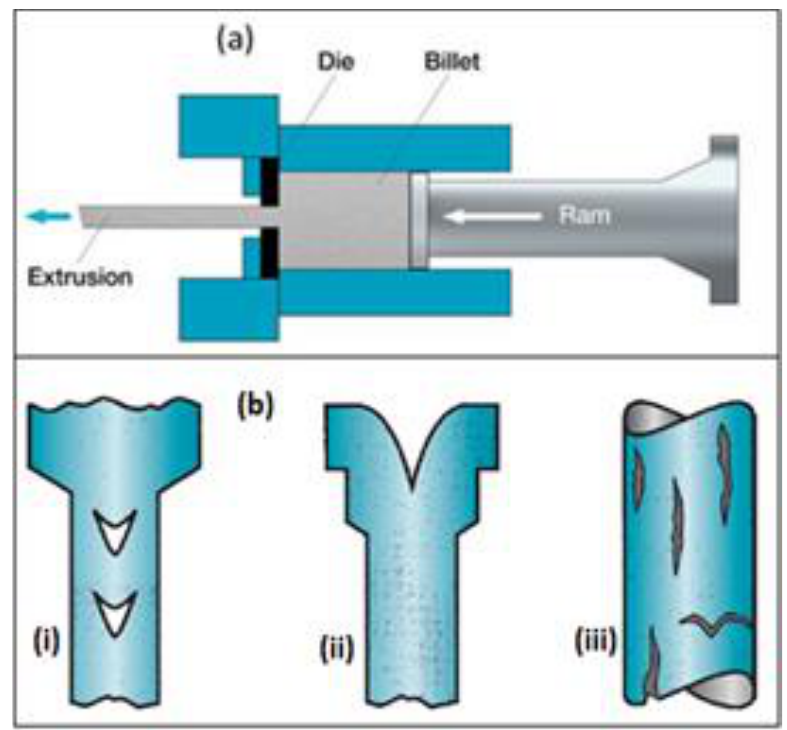
Figure 3. ( a ) Extrusion Process, ( b ) Common Defects in Extrusion, ( i ) Central Burst, ( ii ) Piping, ( iii ) Surface Cracking [52].